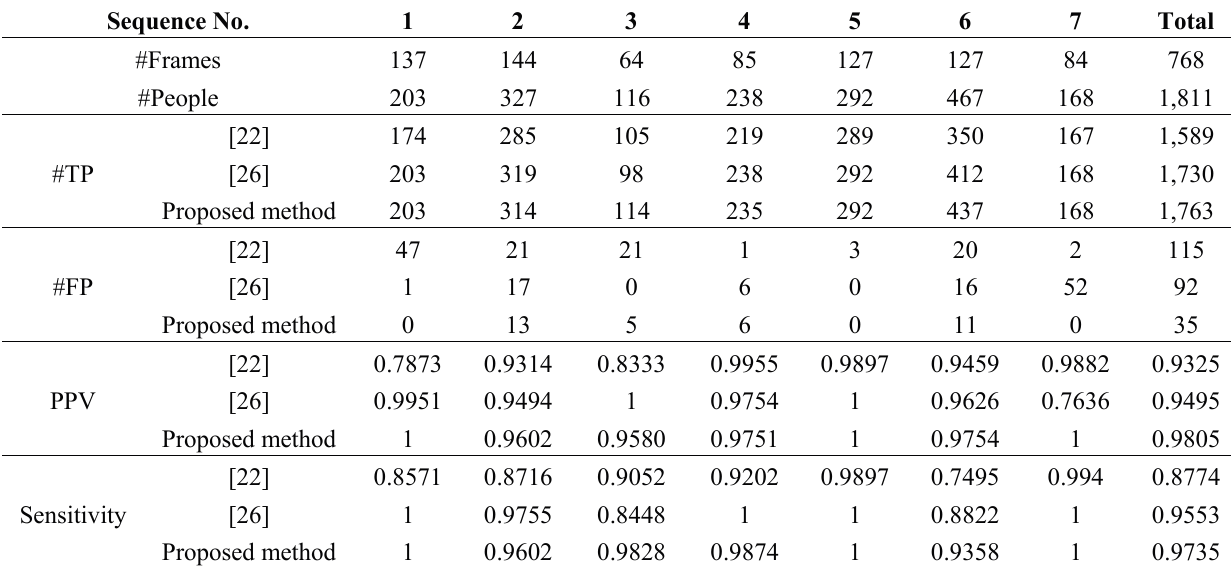
Table 3. Comparison of the detection results for the proposed method and other methods with “our database” (second database).